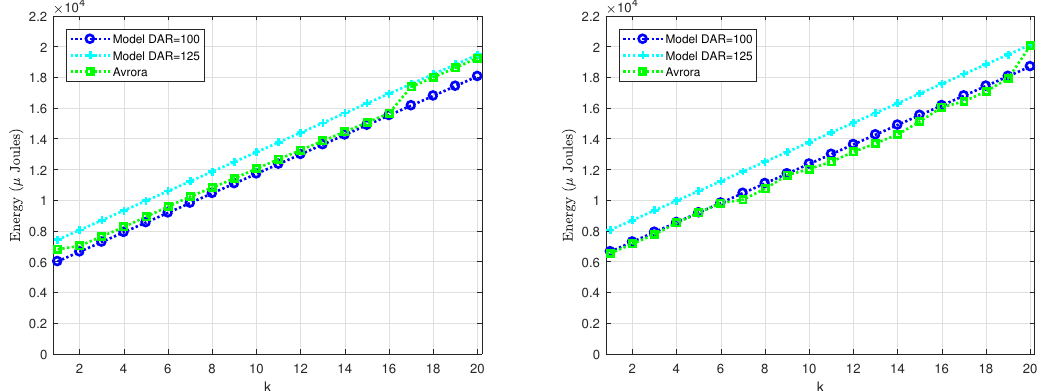
Figure 7. Energy consumption in µ Joules for k tries of a transmitter node ( left ) and a receiver and forwarding node ( right